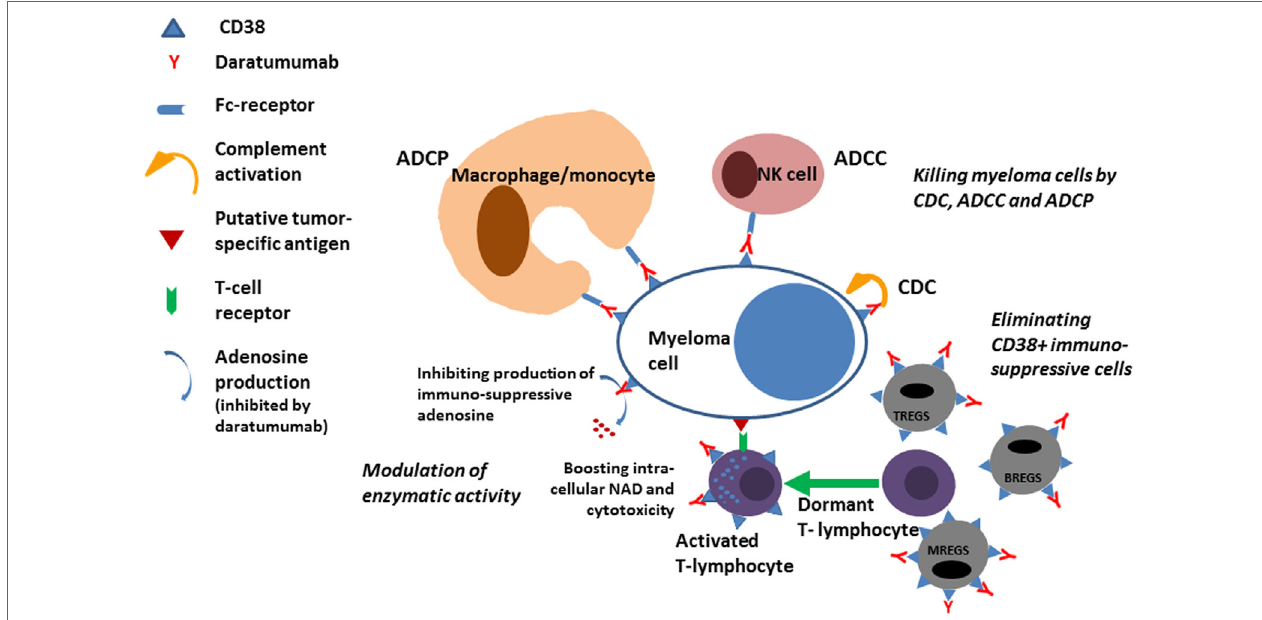
FiguRe 1 | ADCP, antibody-dependent cellular phagocytosis; ADCC, antibody-dependent cellular cytotoxicity; CDC, complement-mediated cytotoxicity; TREGS, BREGS, and MREGS: regulatory cells of the T-cell, B-cell, and Myeloid-derived suppressor cells; NAD, nicotinamide adenine dinucleotide.